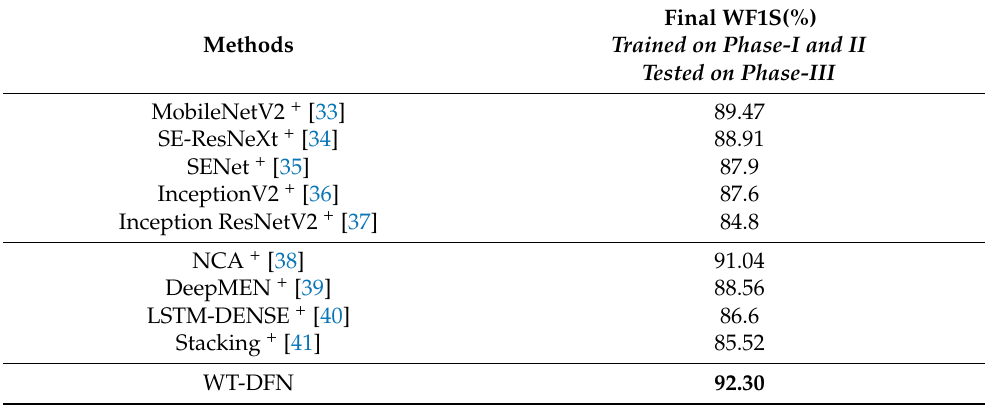
Table 2. Comparison with state-of-the-art methods on the C-NMC final testing